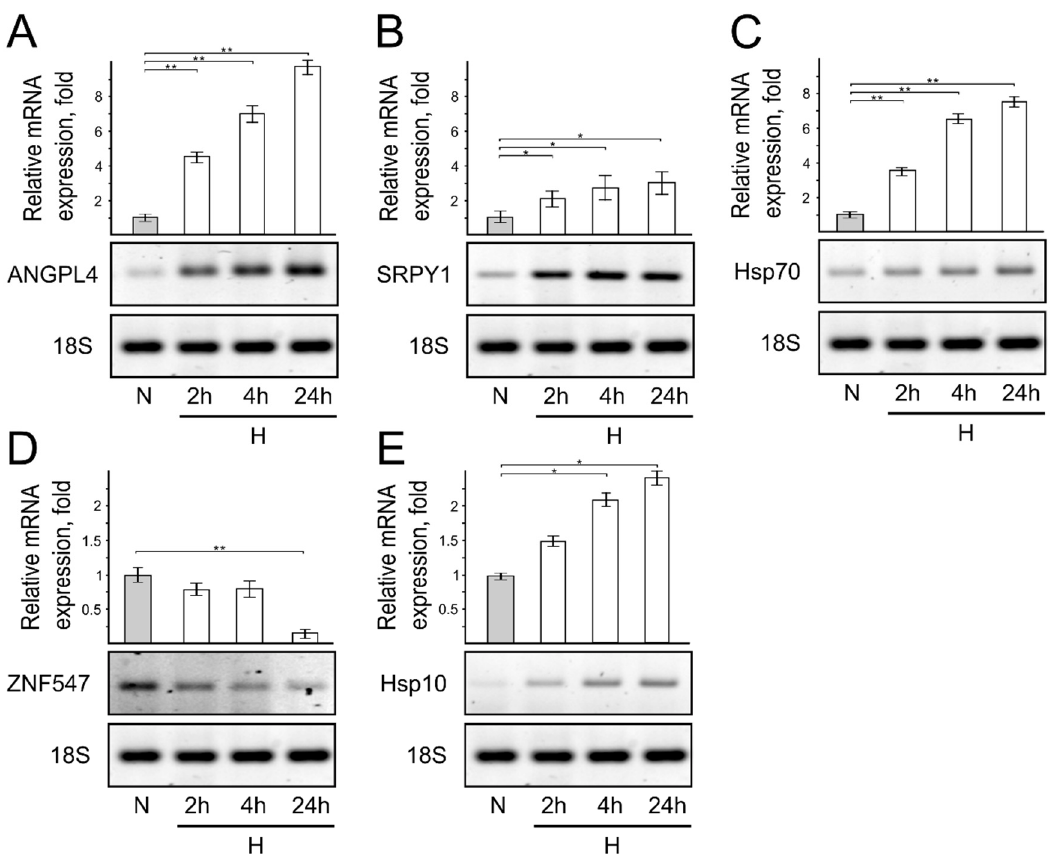
Figure 3. Short-term hypoxia influences ANGPL4, SRPY1, HSP70, ZNF54, and Hsp10 mRNA expression levels in normoxic and hypoxic cells. Reverse transcriptase PCR (RT-PCR) results of endogenous ANGPL4 ( A ), SRPY1 ( B ), Hsp70 ( C ), ZNF547 ( D ), and Hsp10 ( E ) gene mRNA expression in normoxic and hypoxic cells. Bar plot represents the quantification of mRNA expression of 3 independent experiments when mRNA expression calculated in cells grown under normal oxygen conditions is taken as 1. Error bars represent the amount of spread between the extremes of the data, ** p < 0.05, * p < 0.01. N—cells cultivated under normal conditions; H—cells cultivated under hypoxic conditions for indicated time (2, 4 h, and 24 h).